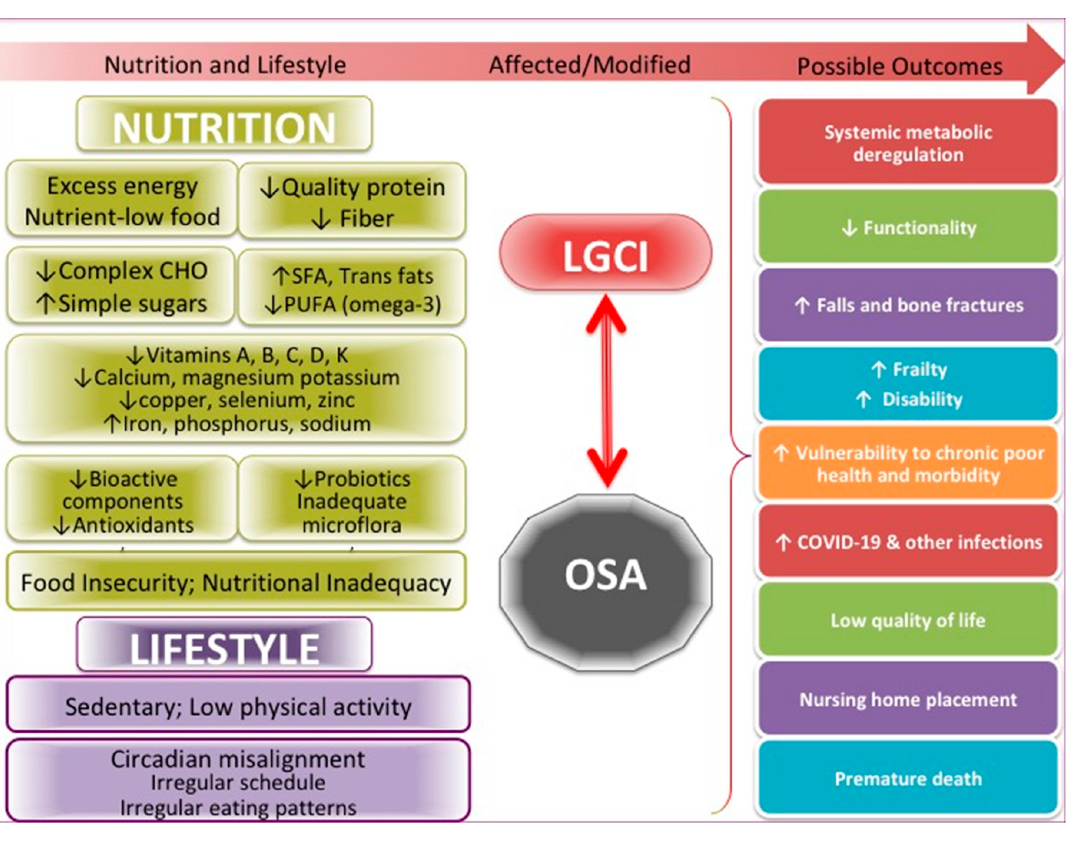
Figure 2. Specific nutritional and lifestyle factors affecting osteosarcopenic adiposity (OSA) and low-grade chronic inflammation (LGCI), leading to the increased risk for multiple adverse outcomes, including COVID-19. SFA, saturated fatty acids; PUFA, polyunsaturated fatty acids. Currently, the duration of the COVID-19 pandemic is uncertain, but its consequences on human